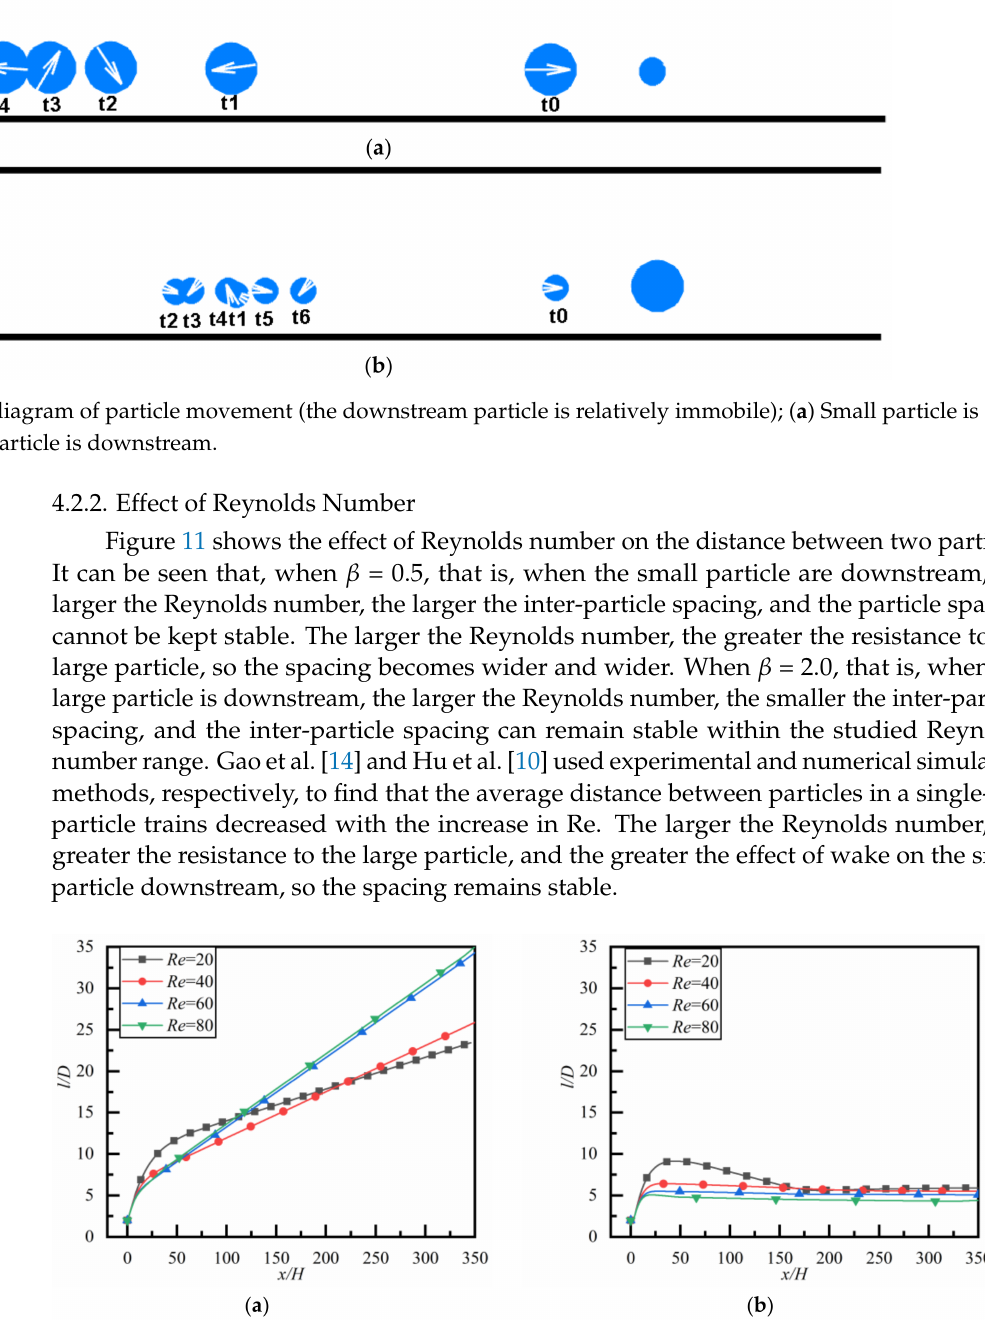
Figure 11. Effect of Reynolds number on the distance between two particles; ( a ) β = 0.5; ( b ) β =